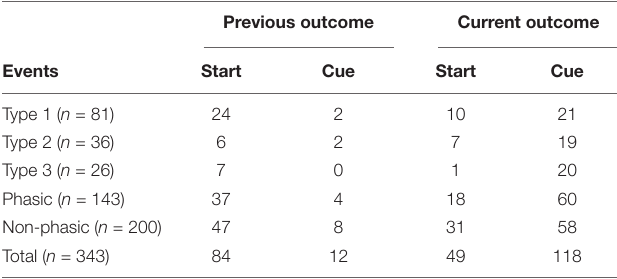
TABLE 1 | Number of neurons modulated by behavioral outcome. Previous outcome Current